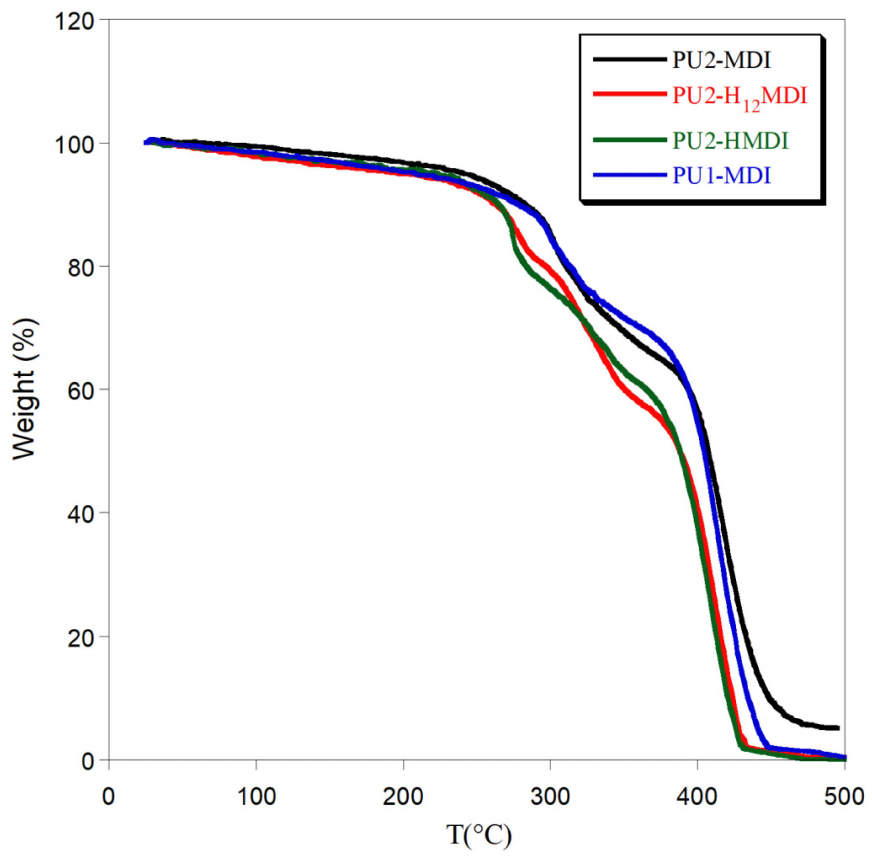
Figure 5. Thermogravimetric curves of